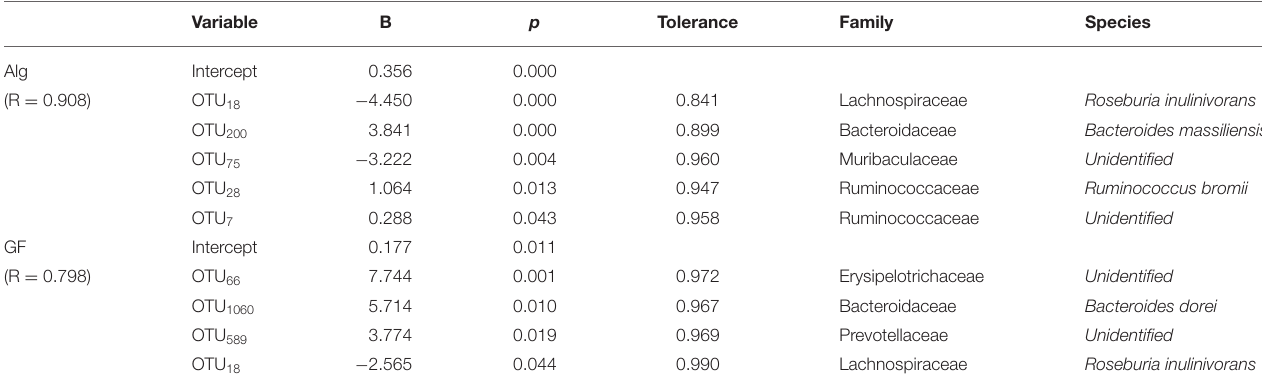
TABLE 1 | A multiple linear regression analysis between bacterial OTUs (%) and alginate (Alg) or galactofucan (GF) consumption (%).